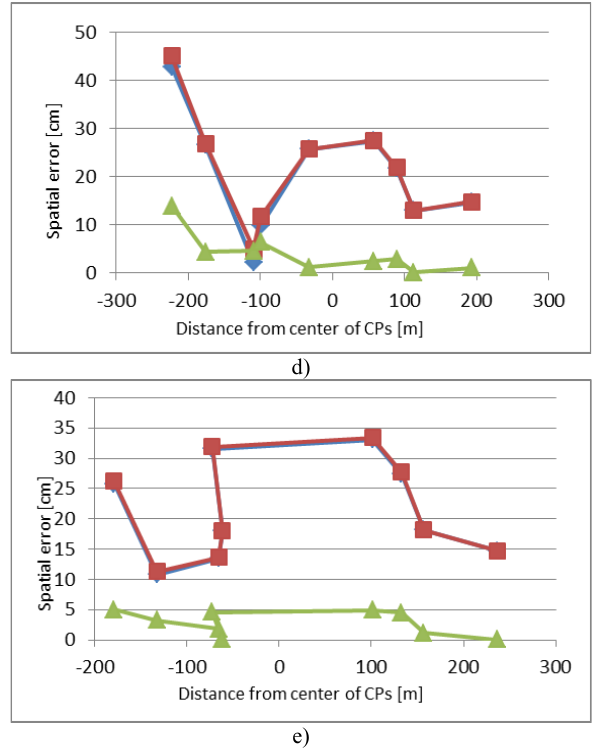
Figure 4. The ChPs error estimation after registration with a) 3 CPs clustered on the north, b) 3 CPs clustered on the south, c) 3 CPs clustered on the middle, d) 3 CPs uniform, e) 8 CPs uniform. The figures have the same ordinary ChPs as the name of 22,24,26,15,11,33,34,35,37 form south to north (left to